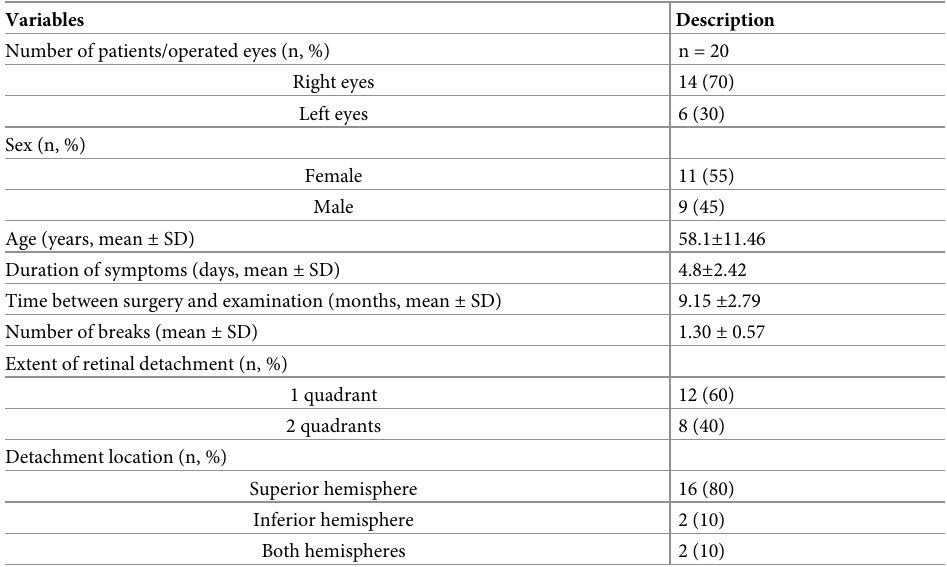
Table 1. Demographic and clinical data of patients.